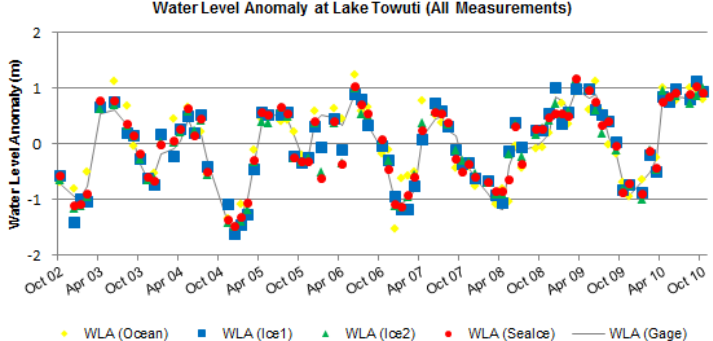
Figure 14. Water level anomaly at Lake Towuti as measured by Envisat RA-2 and processed by all retrackers, compared with in situ